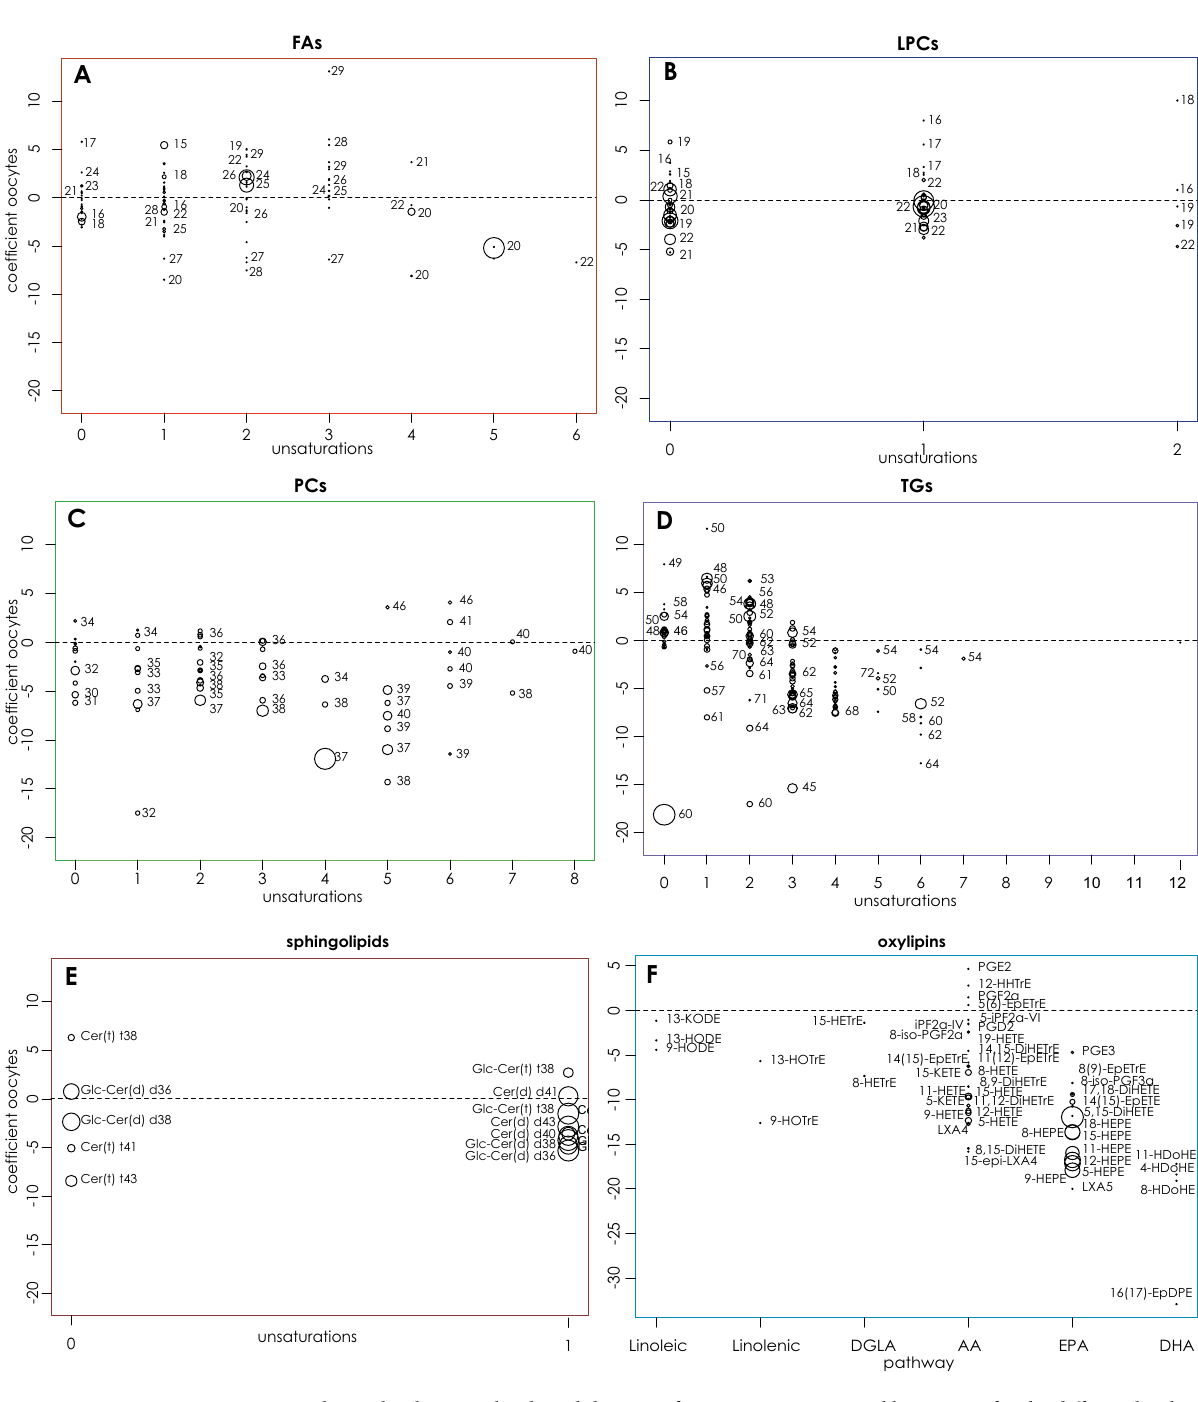
Figure 6. Relationship between lipids and the area of sponge tissue occupied by oocytes for the different lipid categories. ( A ) free fatty acids (FFA); ( B ) lysophosphatidylcholines (LPC); ( C ) phosphatidylcholines (PC); ( D ) triacylglycerides (TGs); ( E ) sphingolipids; ( F ) oxylipins. The graph depicts the coefficient of the regression analysis between the logarithm of the signal of the lipids and the area of the sponge tissue occupied by oocytes (correcting by the location). Values of the regression coefficient above 0 mean upregulation of the lipid signal with the increasing tissue area occupied by oocytes. Similarly, values below 0 mean downregulation of the lipid signal with the increasing tissue area occupied by oocytes. The non-reproductive individuals are included in the analysis as those without oocyte, i.e. area of oocyte = 0. To distinguish major from minor species in the same family, the area of the circles is proportional to the signal of the lipid in the control group. The number next to the circles indicates the number of carbons of the